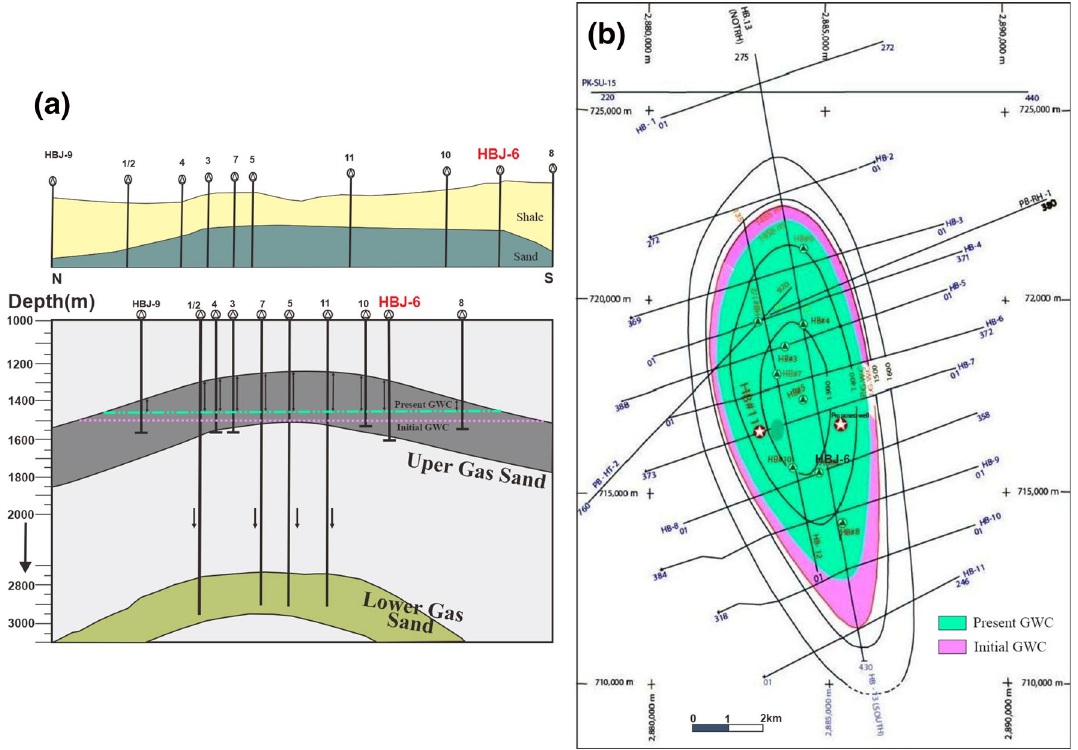
Fig. 2 a Cross-sectional view and b the depth structure on top of upper gas sand of the subsurface formations and the position of wells of the Habiganj gas field, Bangladesh (Imam 2013; Rahman et al. 2017; Gustafson Associates